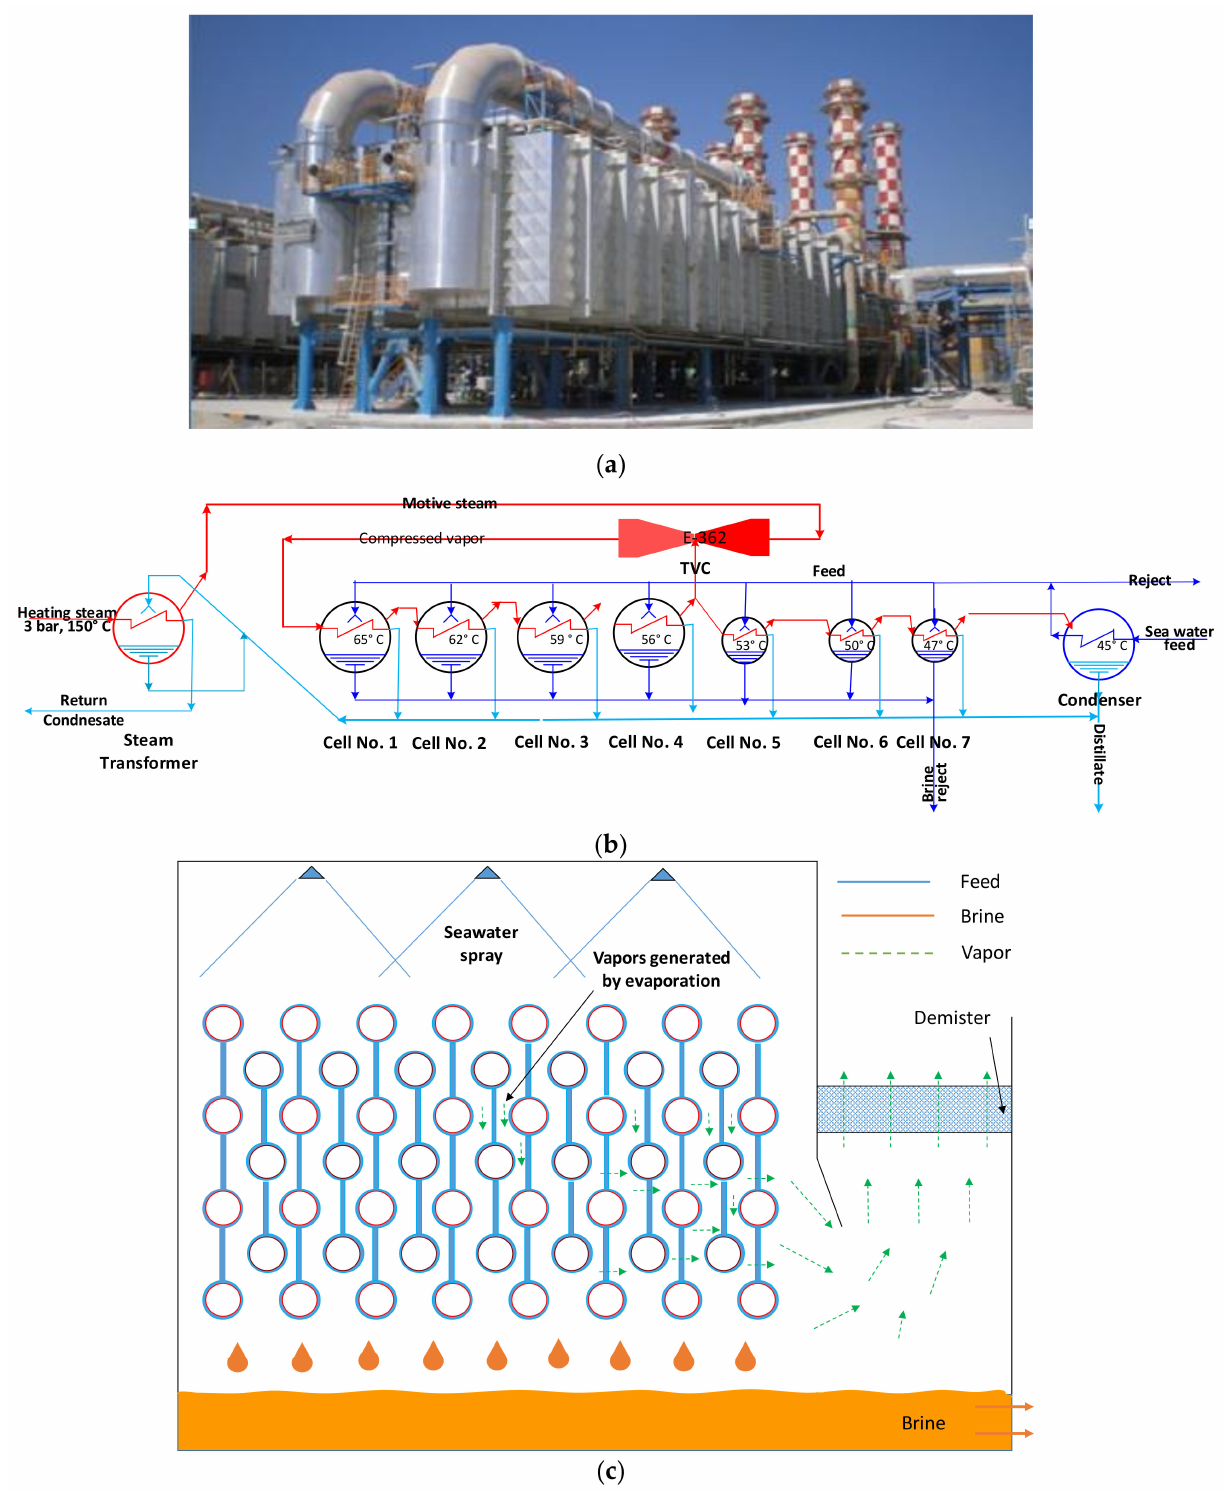
Figure 1. ( a ) Picture of multi-effect distillation (MED)/thermal vapor compressor (TVC) evaporator (6 MIGD (million imperial gallons per day)), Rass Laffan, Qatar; ( b ) process flow diagram of MED falling film evaporator; and ( c ) falling film evaporator